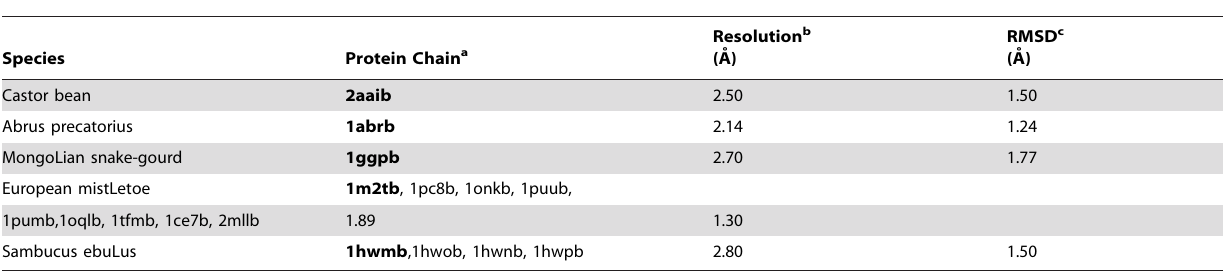
Table 1. Characteristics of Plant Cytotoxin B-chain family.